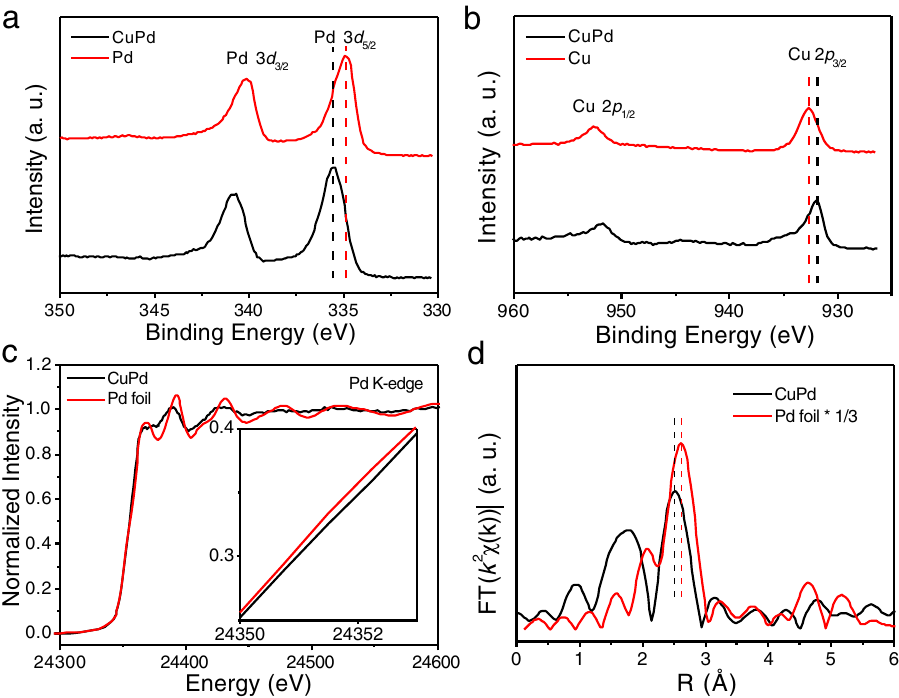
Fig. 4 Structural characterizations of the ordered CuPd nanocubes. a Pd 3 d XPS spectra for ordered CuPd nanocubes and Pd nanocubes. b Cu 2 p XPS spectrum for ordered CuPd nanocubes and Cu nanocubes. c Pd K-edge XANES spectra of ordered CuPd nanocubes and Pd foil reference, with a zoomed-in view of the Pd K-edge as inset. d EXAFS Fourier-transformed k 2 -weighted χ (k) function spectra of ordered CuPd nanocubes and Pd foil Fig. 5a, the ordered CuPd nanocubes exhibit an onset potential of